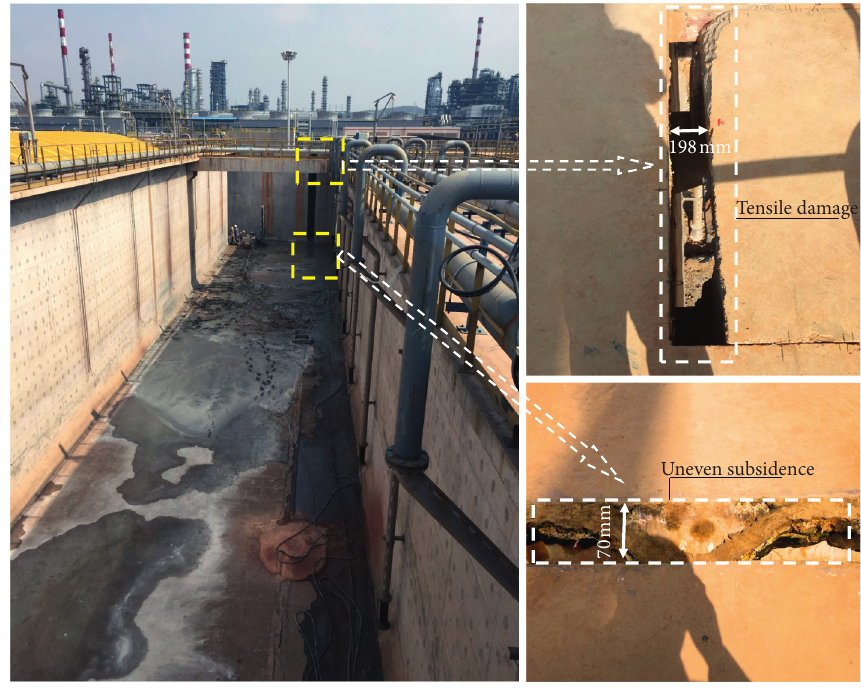
Figure 3: Tensile damage and uneven subsidence of the biochemical pond.